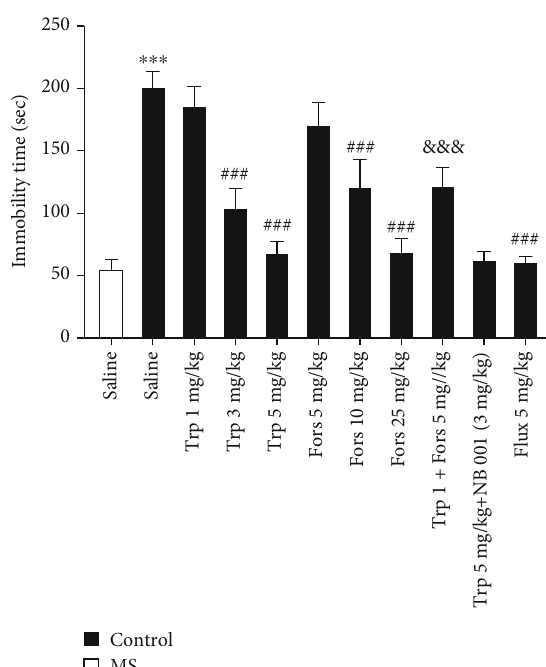
Figure 1: Horizontal activity in the OFT. Values are presented as the mean ± S : E : M : from 6 animals and were analysed using one- way ANOVA followed by Tukey ’ s post test. Drugs were dissolved in physiological saline and injected as a single dose via intraperitoneal (i.p.) route with a volume of 5ml/kg body weight one hour before the test. ∗∗∗ P < 0 : 001 compared with the saline- treated control group, # P < 0 : 05 and ### P < 0 : 001 compared with the saline-treated MS group, and $$ P < 0 : 01 compared with the tropisetron- (5mg/kg) received MS group. MS: maternal separation;